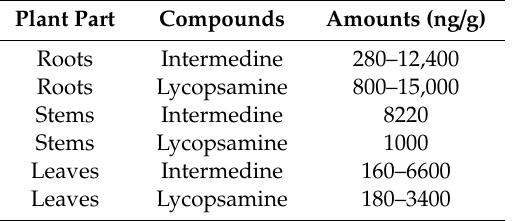
Table 2. Content (ng / g) of pyrrolizidine alkaloids from di ff erent parts of Symphytum o ffi cinale L. [51]. Plant